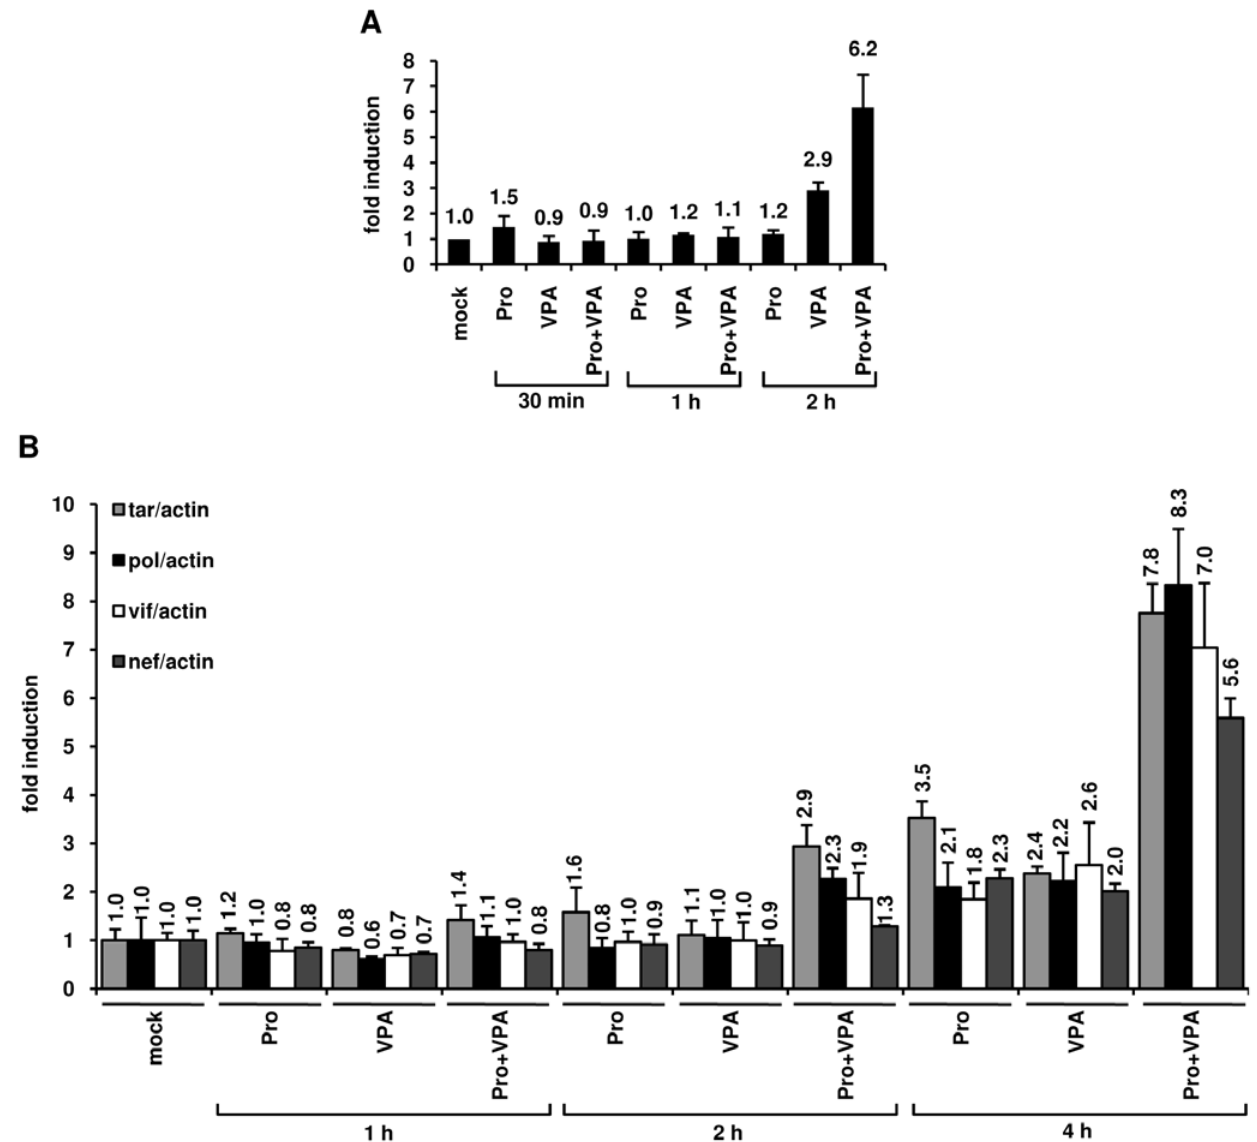
Figure 7. Effects of prostratin + VPA on HIV-1 transcription. ( A ) RNAPII occupancy of the HIV-1 promoter region was assessed by ChIP experiments. U1 cells were mock-treated or treated with prostratin (5 m M), VPA (2.5 mM) and prostratin + VPA for 30 min, 1 h or 2 h. The proteins were cross-linked with formaldehyde for 10 min and DNA sheared. The cross-linked protein/DNA complexes were immunoprecipitated with an anti- RNAPII antibody. The protein/DNA cross-links were reversed and the purified DNA was amplified and quantified by real-time PCR using primers amplifying the region overlapping the LTR U5 region and the primer binding site. Values were normalized to those obtained with the 18S rRNA primers and expressed as fold inductions relative to the value measured in mock-treated U1 cells, which was arbitrarily set at a value of 1. Each value is the mean 6 SE from three separate experiments performed in triplicate. ( B ) Measurement of initiated and elongated HIV-1 transcripts following drug treatments. Total RNA was extracted from U1 cells mock-treated or treated with prostratin (5 m M), VPA (2.5 mM) and prostratin + VPA for 1 h, 2 h or 4 h. Initiated (primers tar) or elongated (primers pol, vif and nef) transcripts were quantified by quantitative real-time RT-PCR. Values were normalized to those obtained with the b -actin primers and expressed for each primer pair as fold inductions relative to the values measured in mock- treated U1 cells, which were arbitrarily set at a value of 1. The results shown are the average of eight independent quantitative real-time PCRs from four separate reverse transcriptions from two independent cell culture treatments. The error bars show the standard errors. An experiment representative of two independent experiments is shown.